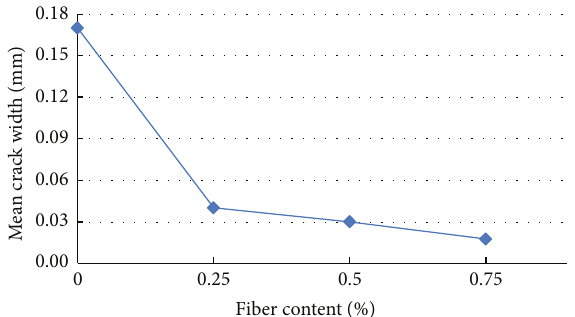
Figure 3: Mean crack width on the surface of mortar after 24 hours.